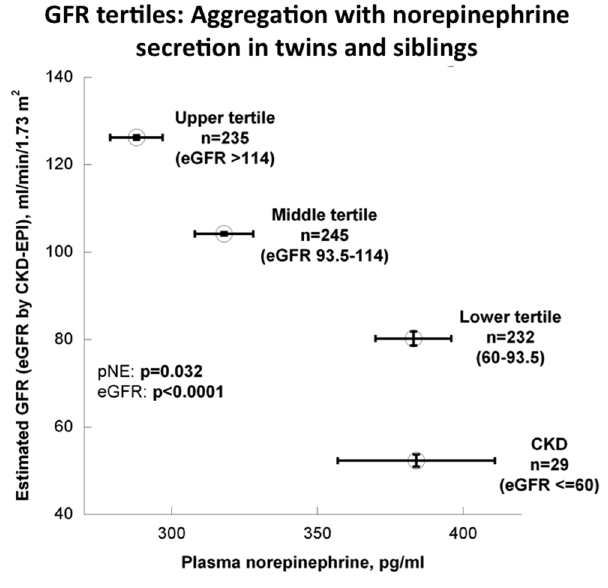
Figure 1. Adrenergic function and GFR: eGFR tertiles. Aggrega- tion of eGFR tertiles with plasma norepinephrine in the entire study cohort, including those with CKD (eGFR # 60).